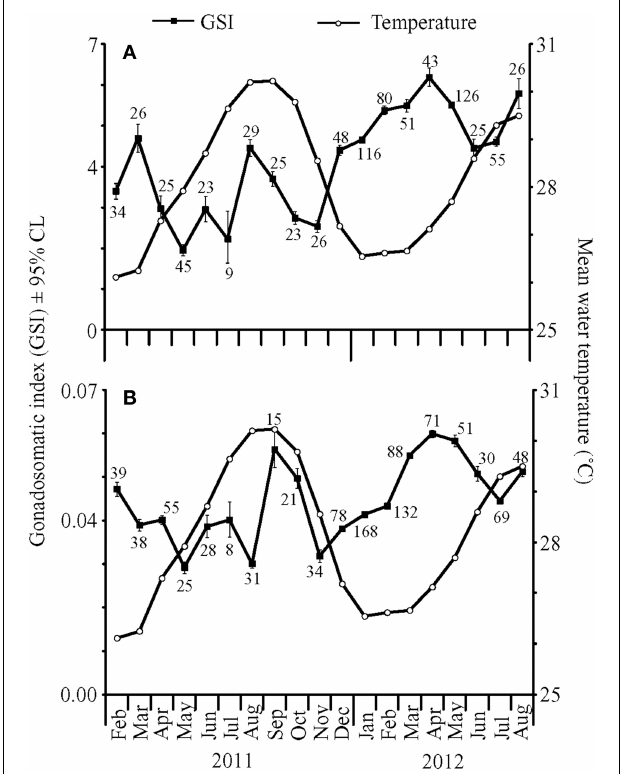
FIGURE 1 | Mean gonadosomatic indices (GSI) ± 95% confidence limits (CL) for (A) female and (B) male fish collected from February 2011 to August 2012 (closed squares), with mean water temperatures ( ◦ C) at 4.6m depth (open circles). Numbers near closed squares represent monthly sample sizes for GSI